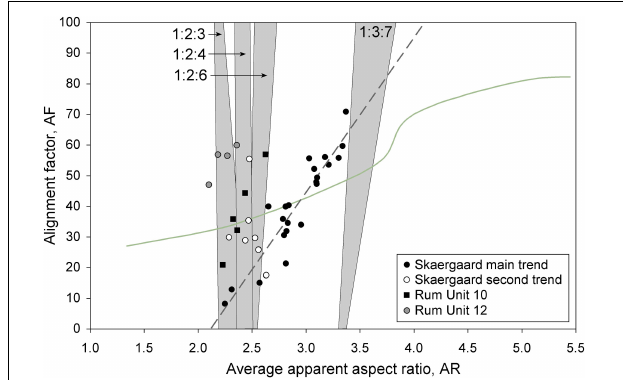
FIGURE 5 | The variation of alignment factor (AF) as a function of average apparent aspect ratio (AR) for the Skaergaard and Rum troctolites. The continuous green line shows the trend reported by Meurer and Boudreau (1998) for Stillwater cumulates. The shaded boxes show the range of correlations expected for rocks containing grains of a constant (cuboid) shape (see labels). The left-side of each box is that calculated without the 5% smallest grain intersections, and the right-side of the box is that calculated without the 20% smallest grain intersections. In all cases, the calculated trend for the synthetic systems with constant grain shape is steeper than that observed for the natural samples, suggesting that the trend in the natural samples is caused at least in part by less equant grains in samples with stronger fabrics. The dashed line shows the best fit through the main group of Skaergaard samples.